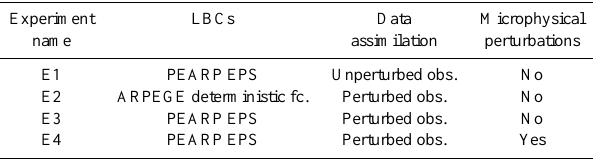
Table 1. Characteristics of the different ensemble